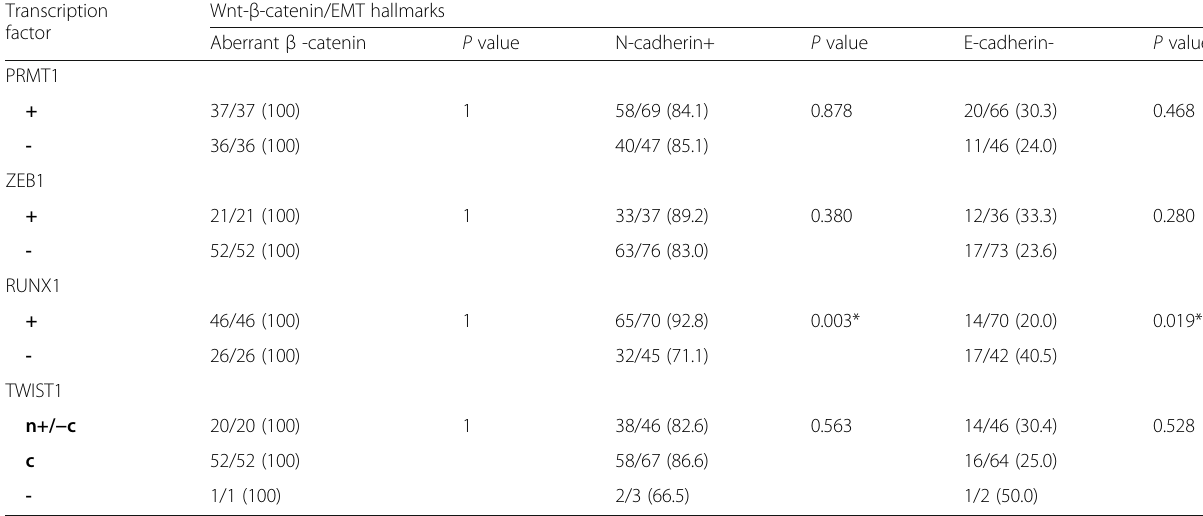
Table 7 Association of PRMT1, ZEB1, RUNX1, and TWIST1 with WNT- β -catenin/EMT hallmarks ( β -catenin, N- and E-cadherin) in